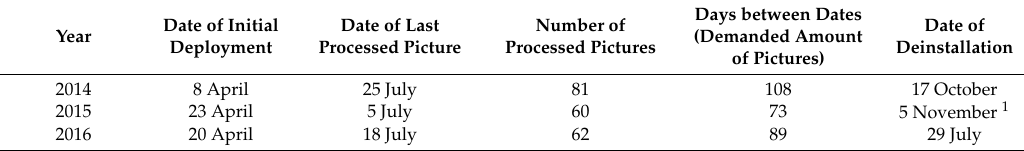
Table 3. Information on the data collection in Fuglebekken